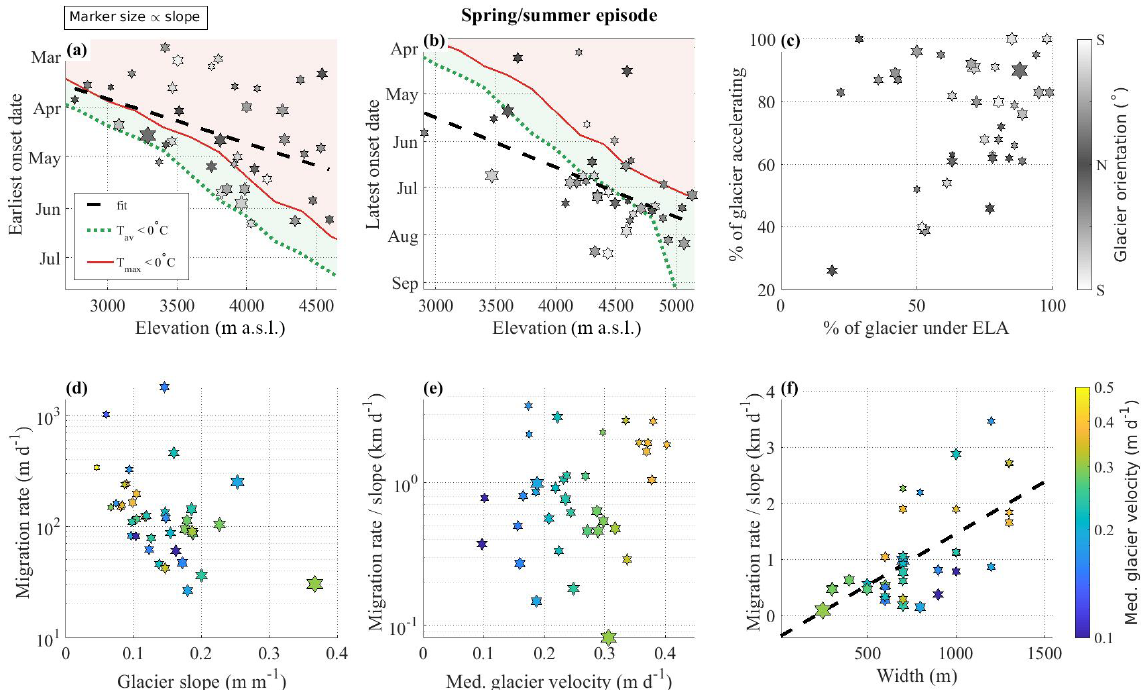
Figure 7. Characteristics of the upglacier migration rate of the spring/summer accelerations measured on 38 glaciers. (a) Earliest and (b) latest onset dates of the accelerations as a function of the glacier altitude where they occur. The dashed black lines show a linear fit with R 2 of 0.17 and 0.33 in (a) and (b) , respectively. The red and green lines in (a) and (b) show when the daily maximum and daily mean temperature start to be positive during the melt season (Fig. S1). (c) Fraction of glacier length over which the acceleration is observed, relative to the fraction of glacier length below the ELA. Marker colors in (a) – (c) show glacier orientation. (d) Migration rate as a function of mean glacier slope. (e, f) Migration rate normalized by mean glacier slope as a function of median glacier velocity and glacier width, respectively. The dashed black line shows a linear fit with R 2 of 0.63. Marker colors in (d) – (f) show the median value of the velocity reached during the acceleration. The size of the marker represents the slope of the glacier: the smaller the marker, the shallower the slope.